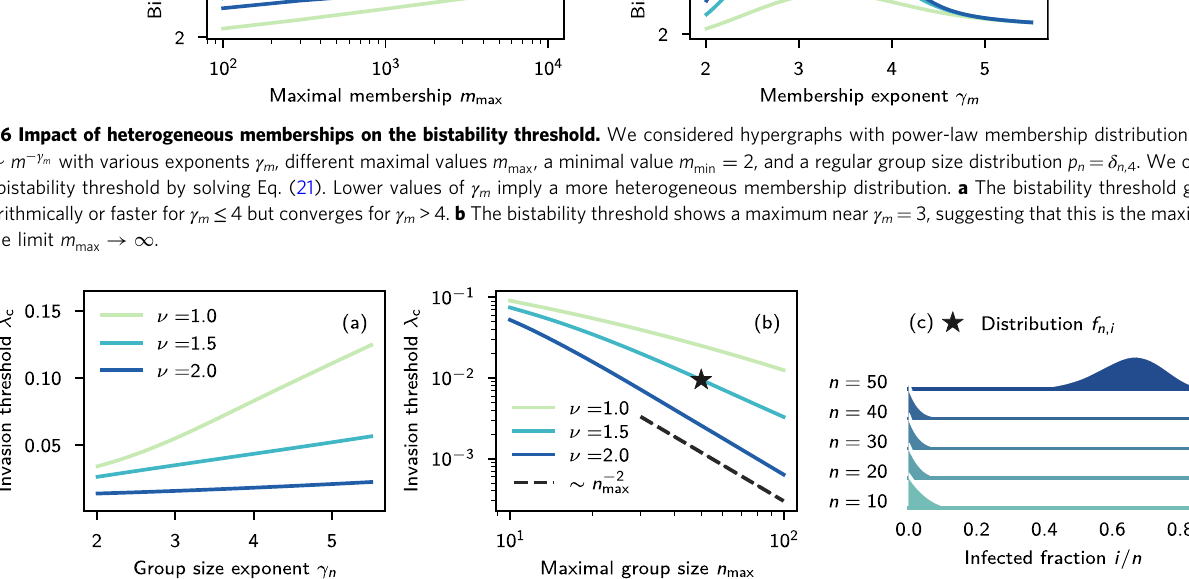
for large n max , indicating the onset of max